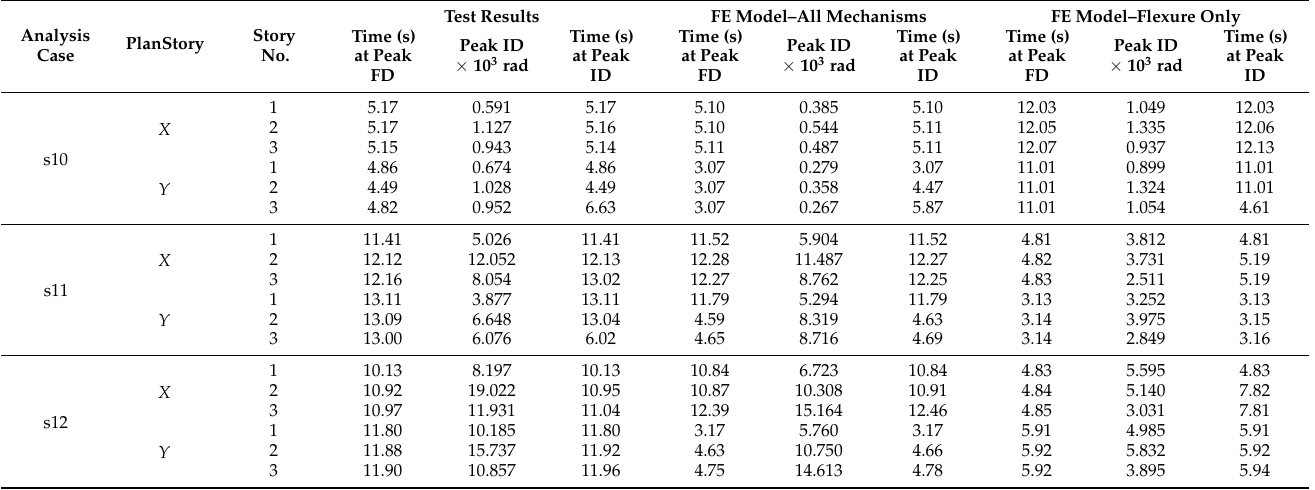
Table 3. Peak floor displacements and inter-story drifts in the two plan directions of the SPEAR